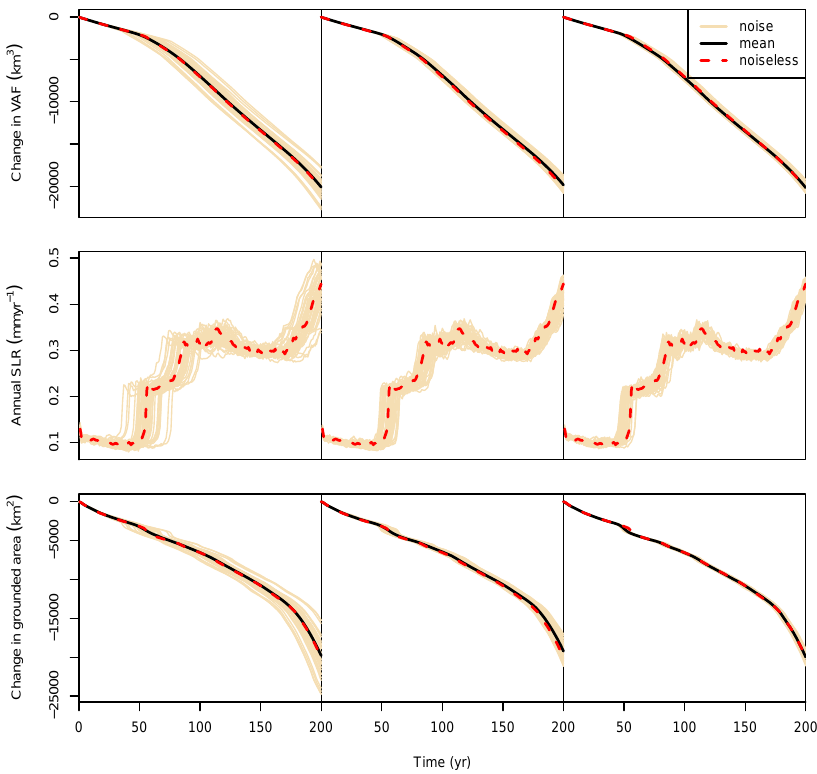
Figure 6. Change in ice volume above floatation (VAF), annual sea level rise (SLR) and change in grounded area for the PIG basin (Fig. 2a, d). The three columns are for experiments with lower- (left), medium- (middle) and higher- (right) frequency noise on the bedrock. Higher- frequency noise leads to less variation than low-frequency noise, while the mean over all of the experiments with noise added is close to the noiseless experiment. Much of the variation is associated with the onset of rapid retreat at around 50 years, evident in the plot of annual SLR.